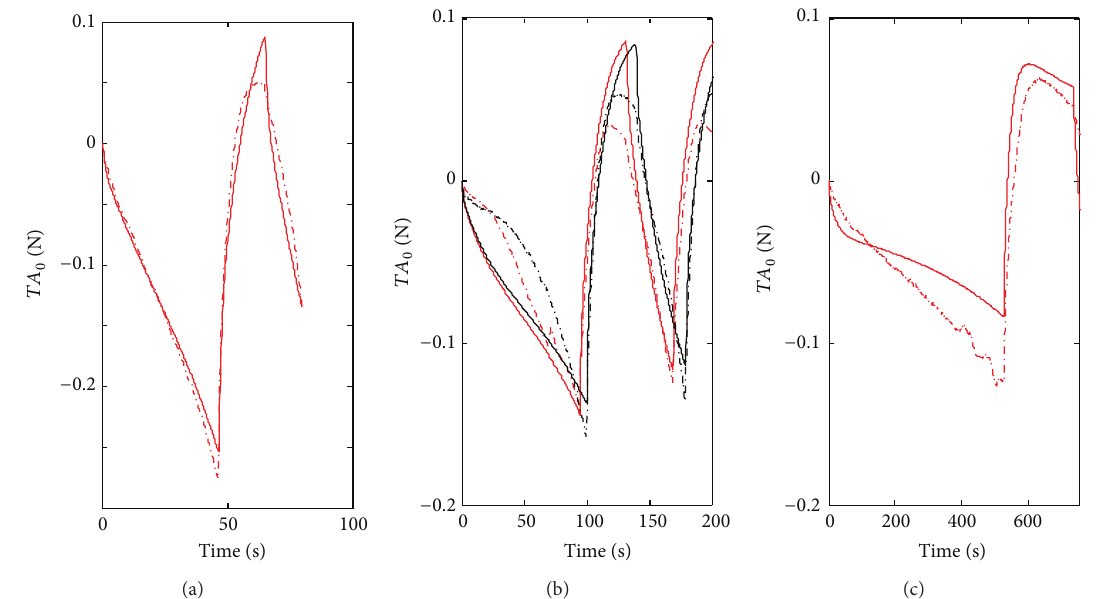
Figure 8: Grey box nonlinear system identification using Neo Hookean inspired model (model 1 with structure given by (7) and 𝐶 2 = 0 ). (a) Identification data. Measured and estimated data are shown in dashed-dotted and continuous red line, respectively. Validation data of sample 2 (red) and sample 3 (black) are shown in (b), with the same lines code. (c) shows the validation data of sample 4.